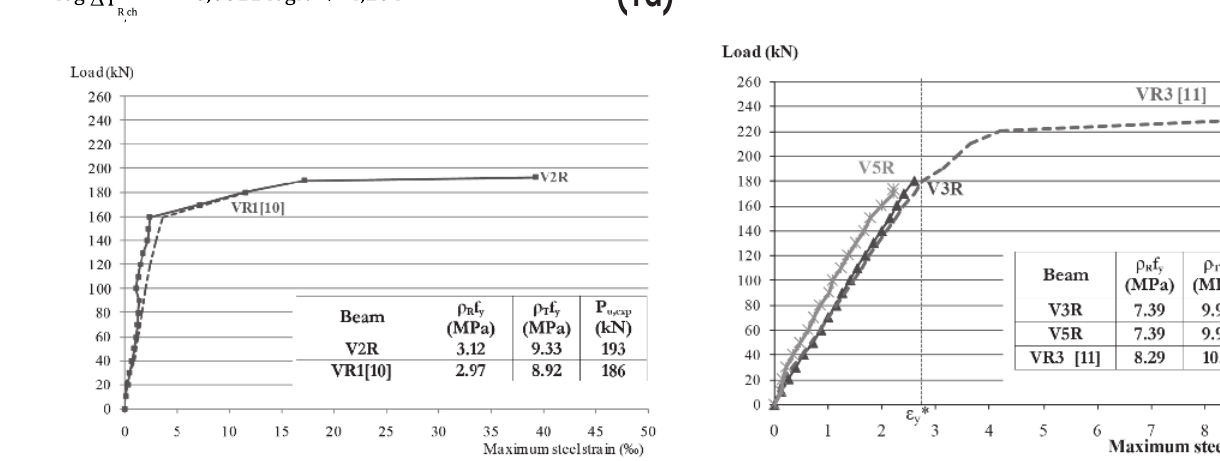
Load - maximum longitudinal steel strain curves for beams VR1 [10] and V2R